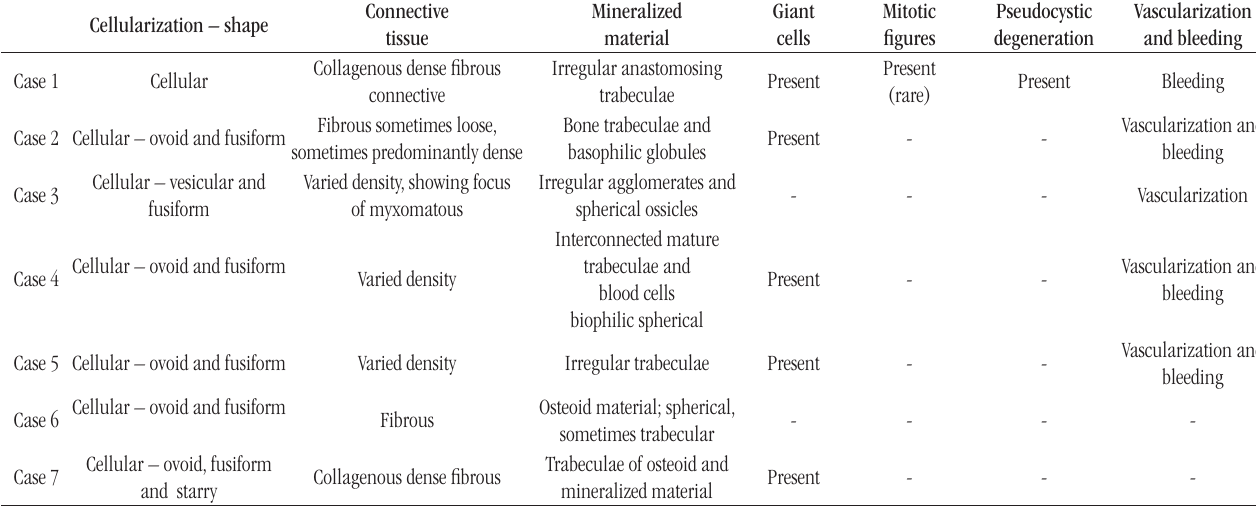
taBLE 2 – Morphological aspects of